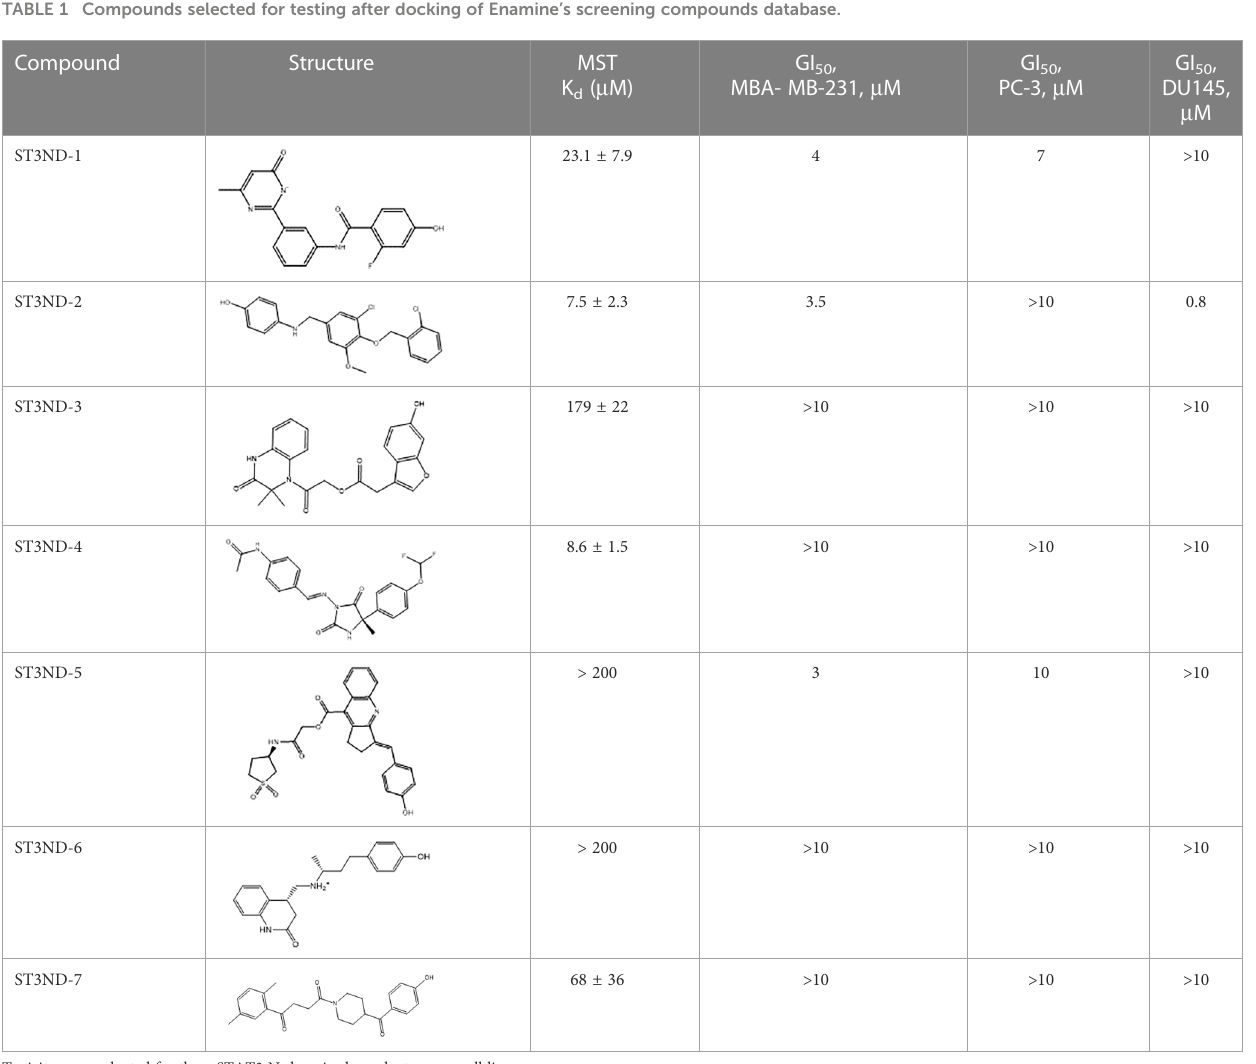
TABLE 1 Compounds selected for testing after docking of Enamine ’ s screening compounds